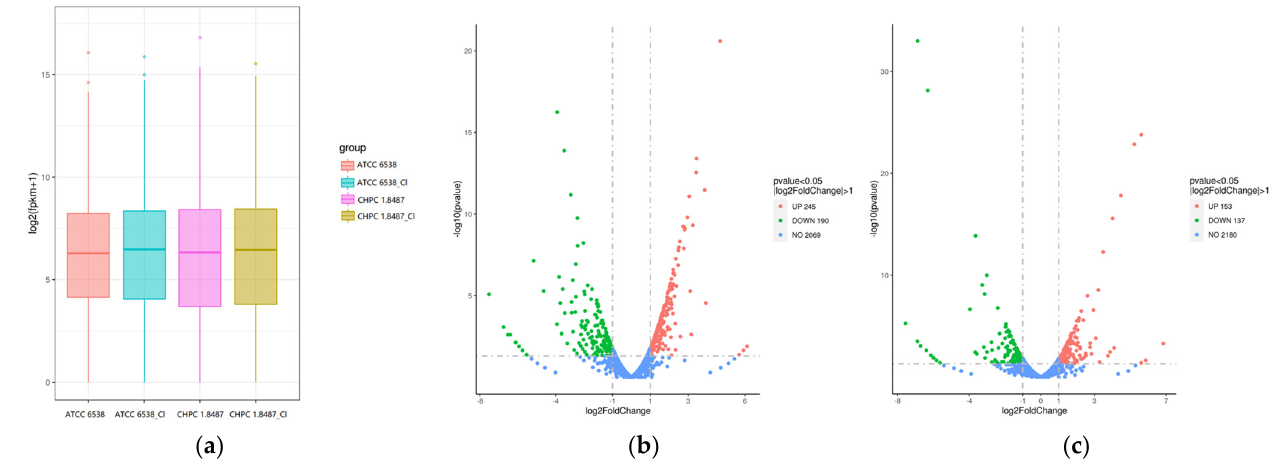
Figure 4. Gene expression analysis. ( a ) Box plot of the gene expression distribution. ( b ) Volcano plot of the genes differentially expressed in ATCC 6538. ( c ) Volcano plot of the genes differentially expressed in CHPC 1.8487. The red and green colors represent the upregulated and downregulated genes in ( b , c ),